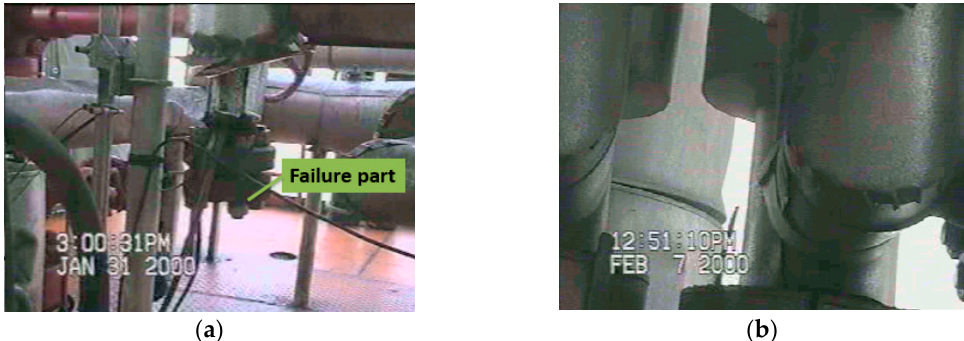
Figure 2. Sea-ice damage to platforms in Bohai: ( a ) Rupture of a blow down pipeline. ( b ) The loose flange.